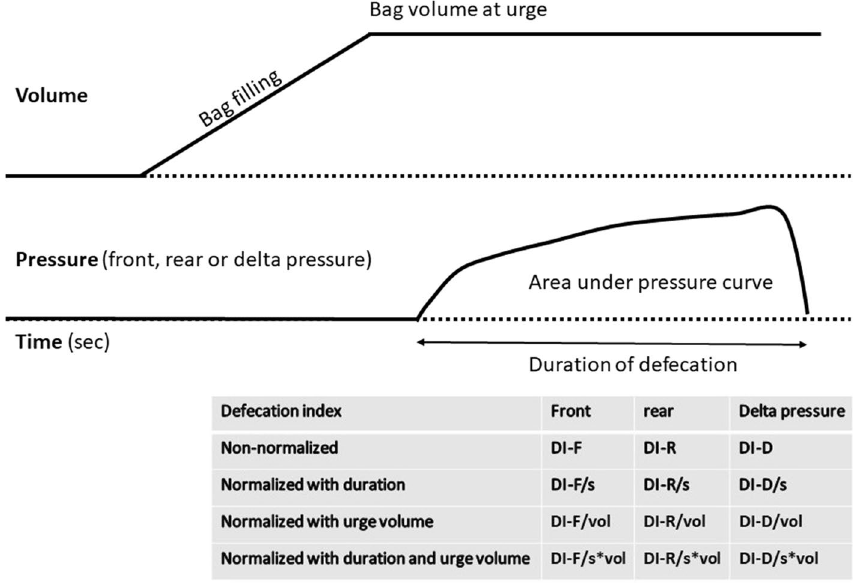
Figure 3. Schematic of the volume and pressure changes during bag filling and defecation of Fecobionics to ease the understanding of the defecation indices (DIs). The area under curve of either the front, rear and delta pressure was computed. They were normalized with respect to defecation duration and urge